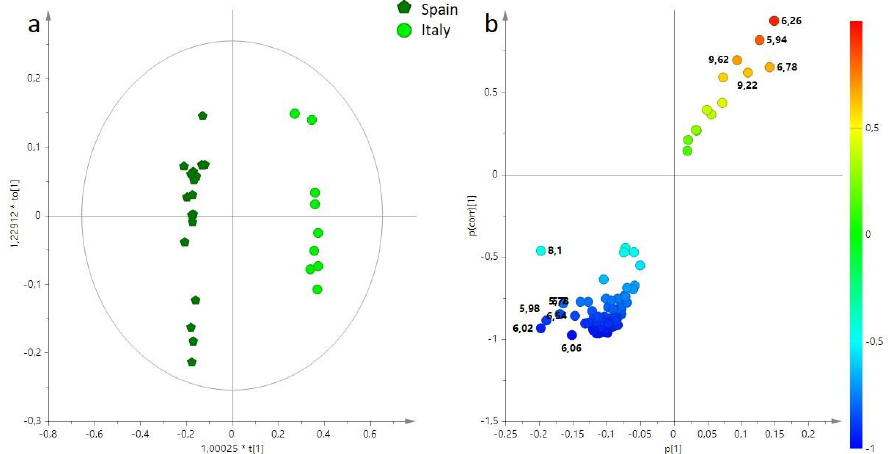
Figure 6. ( a ) OPLS-DA t[1]/to[1] PCA score plot performed on minor components (BUCKET-2) of Arbequina EVOOs samples obtained from Spain and Italy, ( b ) S-plot for the OPLS-DA model colored according to the correlation-scaled loading vector (p(corr)). The variables indicated the chemical shift value (ppm) in the 1 H NMR spectrum.